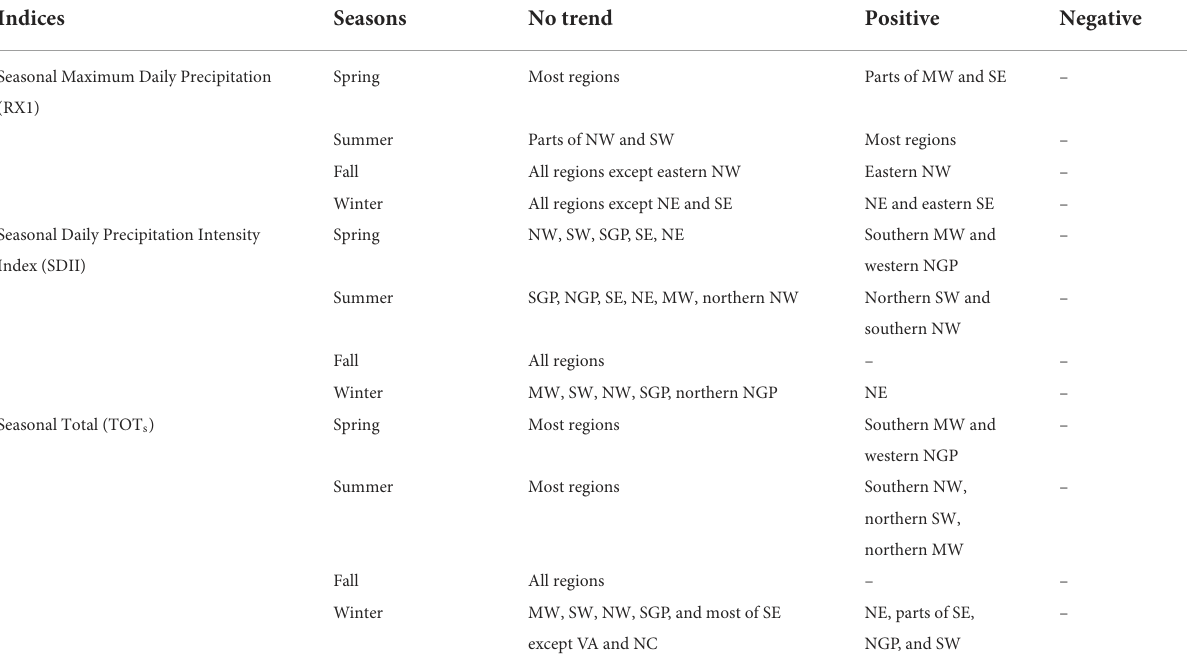
TABLE 1 Ensemble agreement on the signs of change (no trend, 0; positive trend, + 1; and negative trend, − 1) across the indices, i.e., RX1 (mm), TOT s (mm), and SDII (mm/day) in each